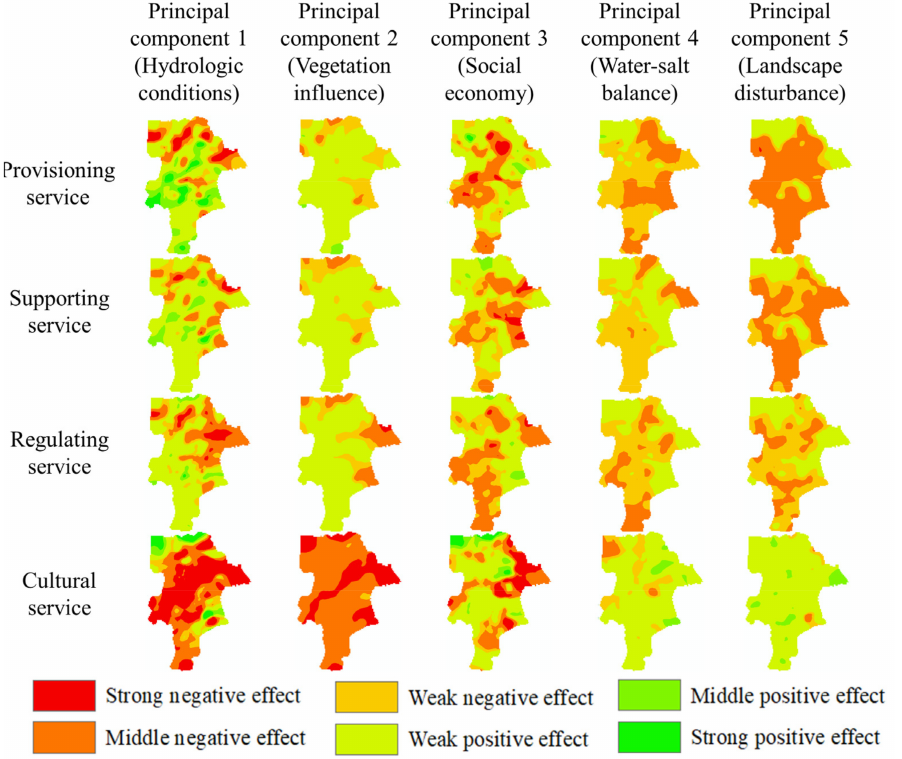
Figure 8. Spatiotemporal variation in the impact of principal components on ecosystem